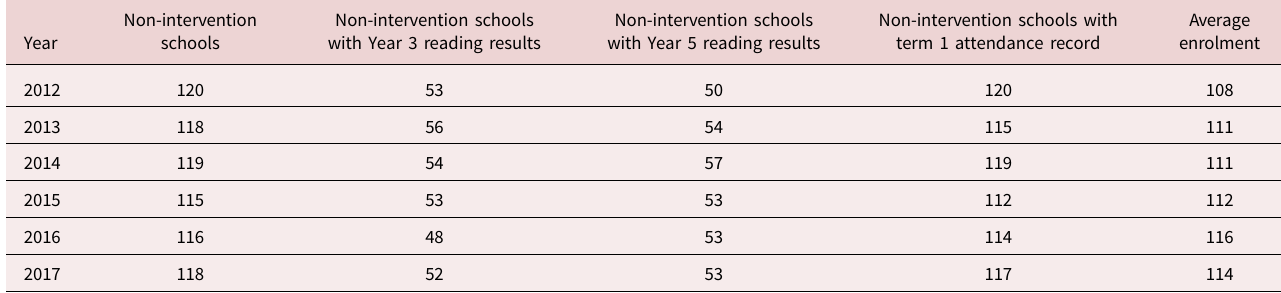
Table 2. Very Remote non-intervention schools with >80% Aboriginal and Torres Strait Islander student enrolments Non-intervention Year